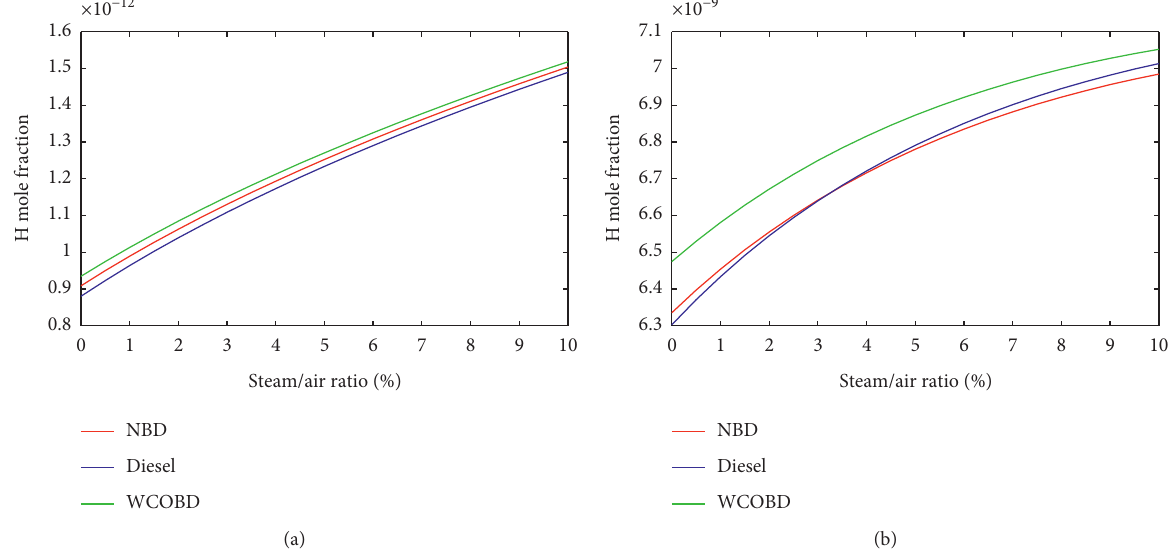
Figure 7: Variation of H equilibrium mole fractions with steam injection ratios.